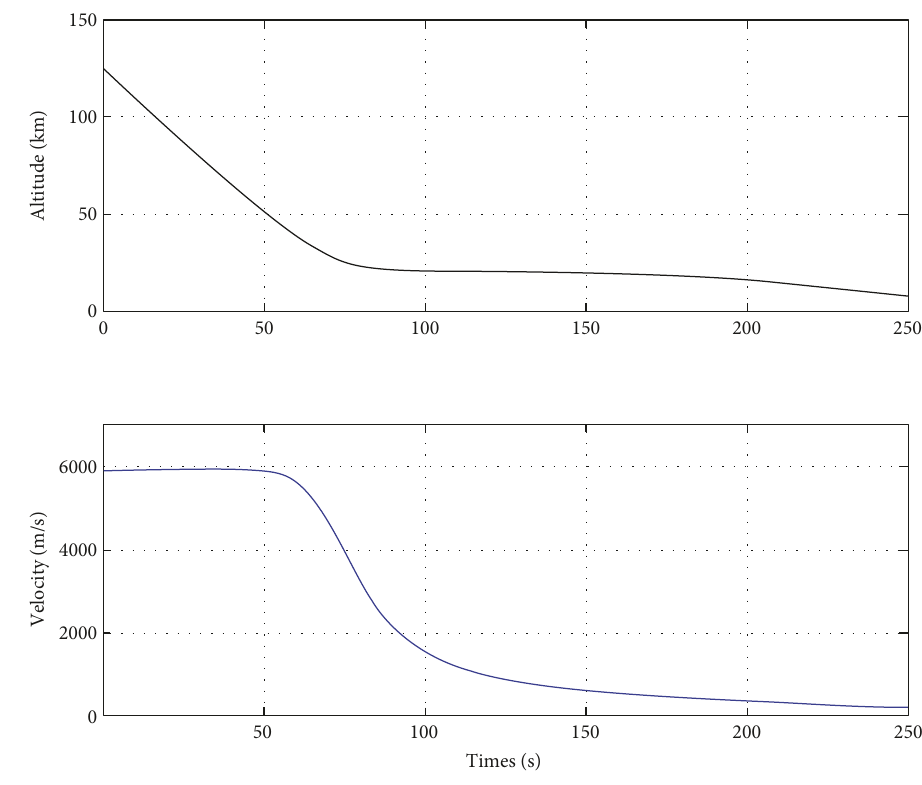
Figure 3: Atmospheric relative velocity and altitude of the entry vehicle.